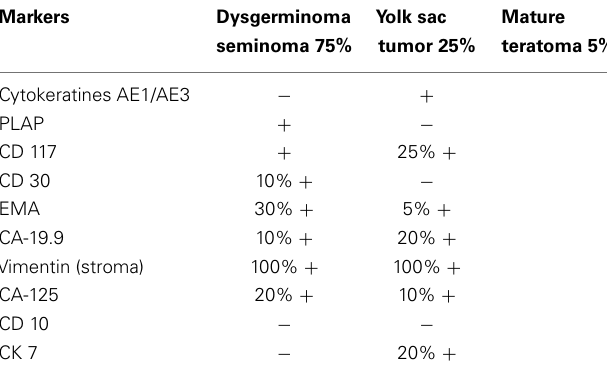
Table 1 | Markers of germ cell tumor (A) .